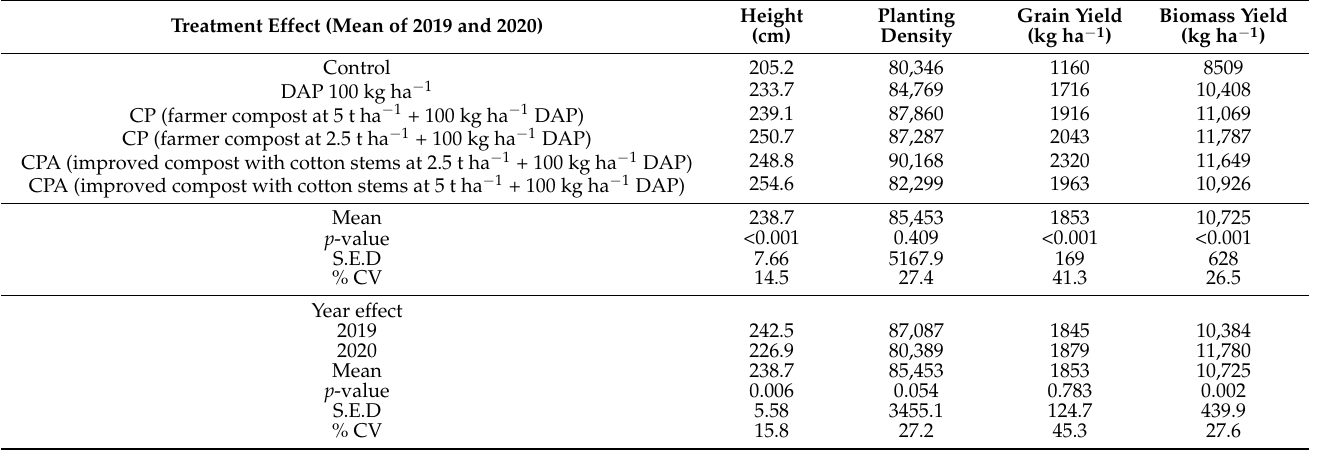
Table 4. Effect of compost application on agronomic parameters of